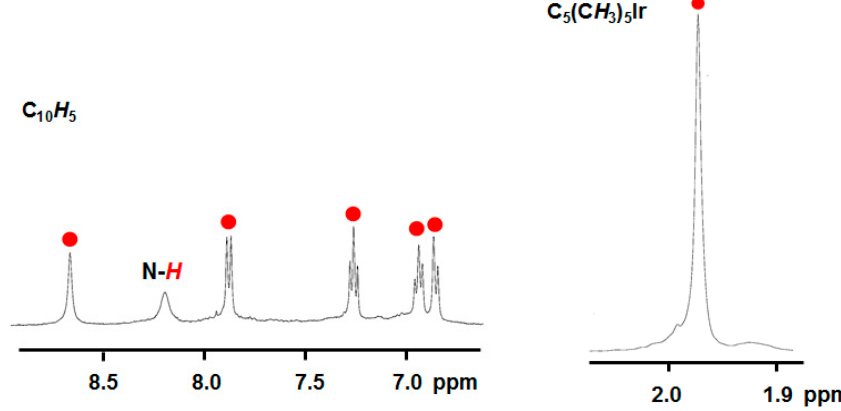
Figure 1. Selected 1 H NMR spectrum of 6 in CD 2 Cl 2 .